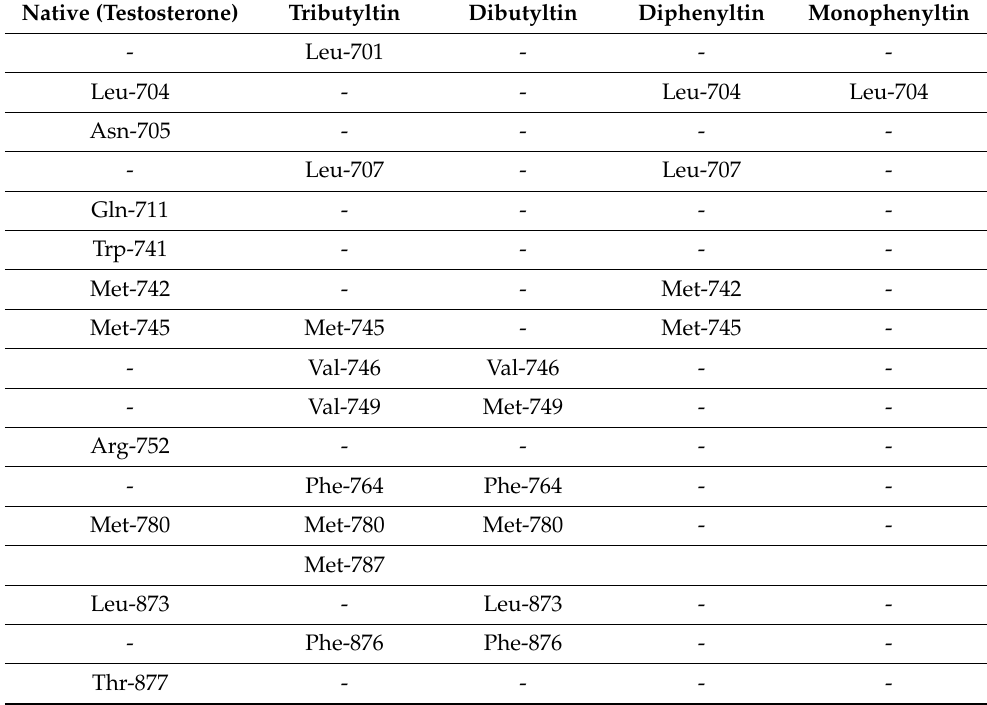
Table 2. Comparative list of amino acid residues of androgen receptor interacting with bound native ligand (testosterone), tributyltin, dibutyltin, diphenyltin, and monophenyltin. Residues within a row among native ligand and organotin ligands are overlapping interacting residues for the compounds. Native (Testosterone) Tributyltin Dibutyltin Diphenyltin Monophenyltin -